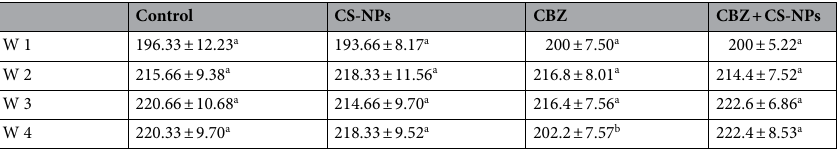
Table 2. The effect of carbendazim (CBZ) and/or chitosan nanoparticles (CS-NPs) on the average body weights. All data are presented as mean ± SEM (n = 5 rats/ group). Values bearing different superscripts (a, b) at the same row means significant at P ≤ 0.05.